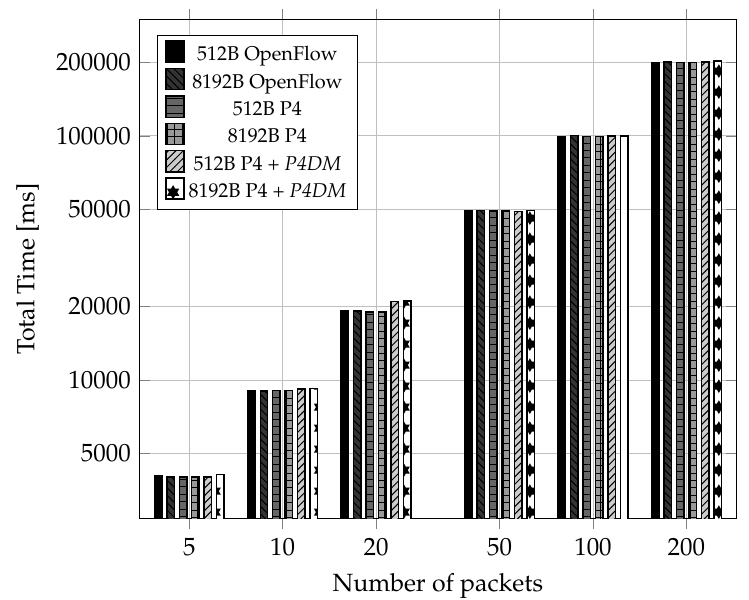
Figure 10. Protocol enabled switches transmission time tests.